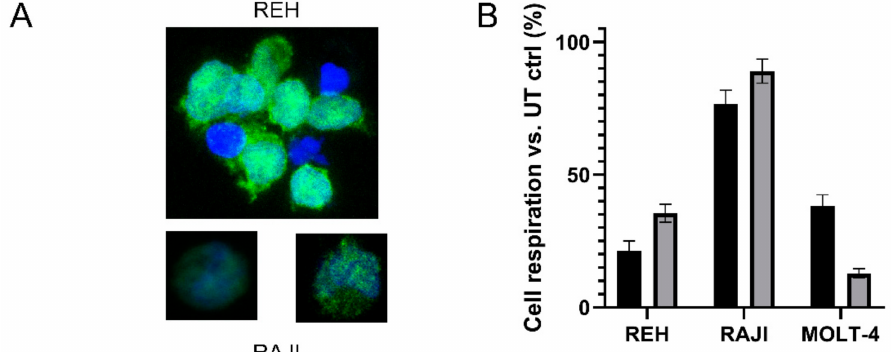
Figure 5. ( A ) Immunostaining of REH and RAJI cells with 488-labelled T-CAN (green). Nuclei counterstained with Hoechst (blue). ( B ) T-CAN (0.3 U/mL, black bars) cytotoxicity (MTT test) compared to that of the full-length, untargeted enzyme (Kidrolase, grey bars) on cell lines positive (REH and RAJI) or negative (MOLT-4) for